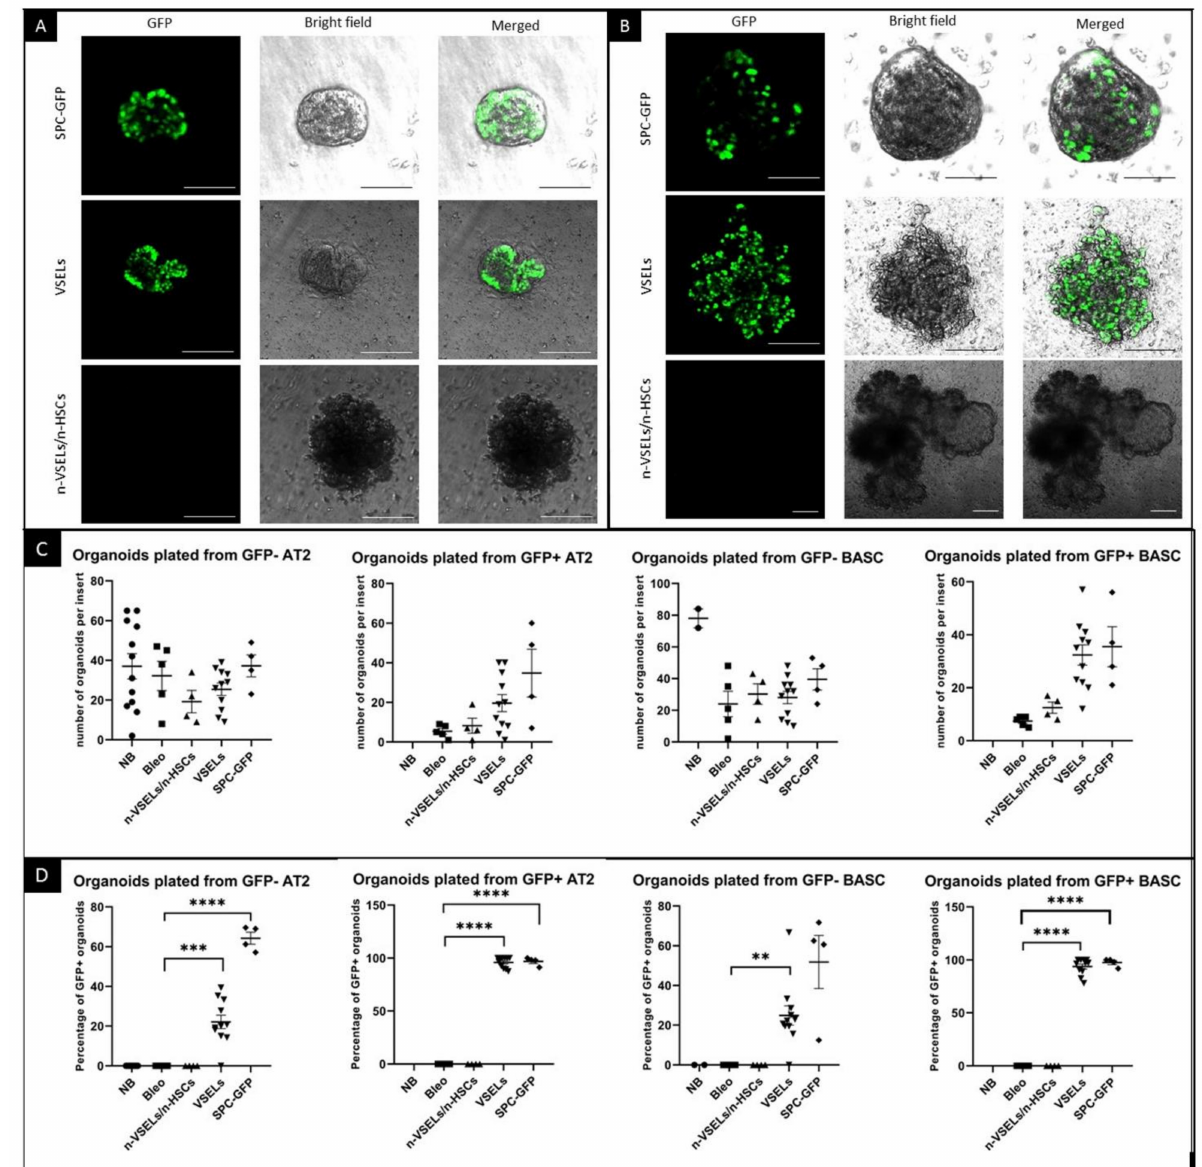
Figure 6. Endogenous GFP fluorescence in organoids and quantification of cultured organoids. Photographs of unstained organoids established from sorted AT2 cells ( A ) and BASCs ( B ) isolated from SPC-GFP donor mice as well as VSEL and non-VSEL/non-HSC recipients as indicated. Photographed organoids are in tissue culture inserts, and green signal is from endogenous GFP. Each image shows an overlay of brightfield and GFP images from the same field of view. Scale bars represent 100 µ m in Panel A and two upper rows of Panel B . Scale bars in bottom row of Panel B represent 200 µ m. Quantification was done before organoids were removed from inserts for sectioning. Panel C. Graphs showing number of organoids grown for each mouse. Panel D. Graphs show percentage of organoids with endogenous GFP signal for each mouse. ** p < 0.01, *** p < 0.05 **** p <